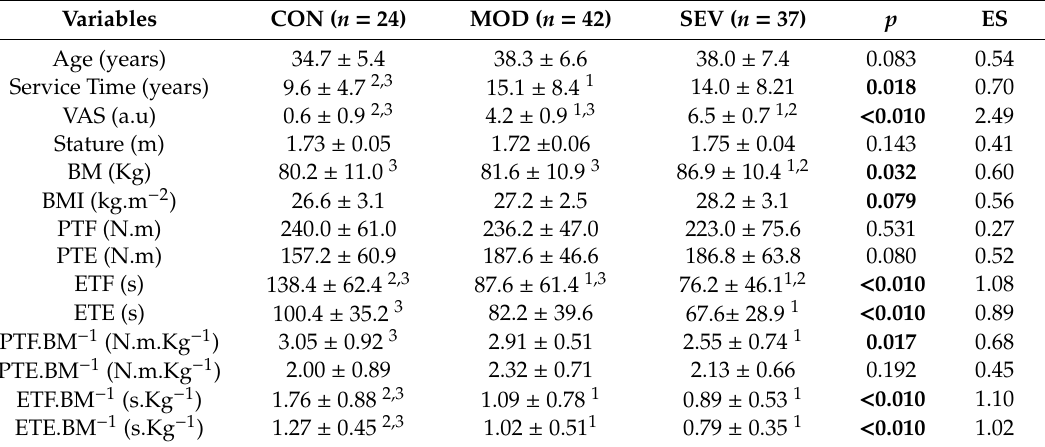
Table 1. Physical characteristics and performance on peak torque and endurance tests of the trunk flexor and extensor muscles of the control (CON) group, and the groups with moderate (MOD) and with severe (SEV) chronic low back pain (CLBP).